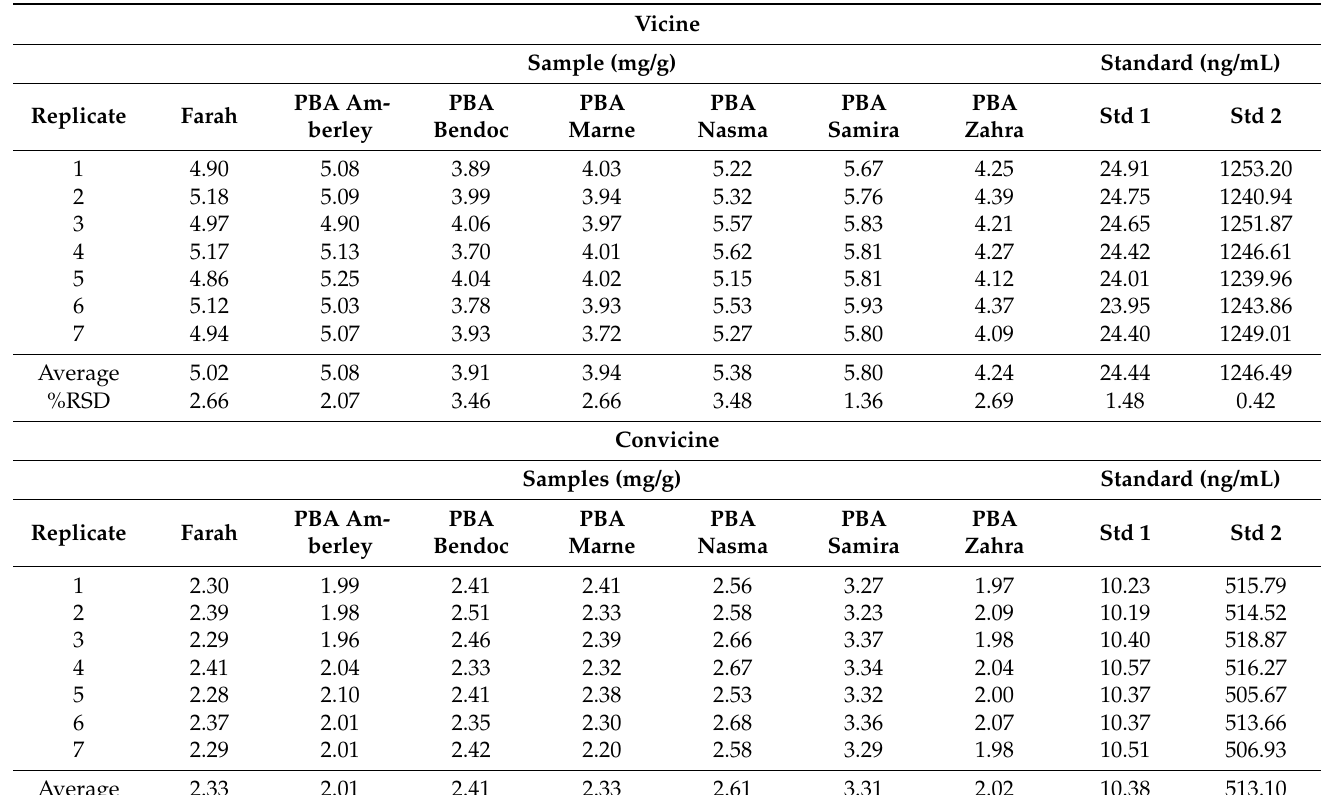
Table 4. Replicate analysis of seven commercially available Australian faba bean cultivars and two standards at the lower (Std 1) and upper (Std 2) limit of the linear range for vicine and